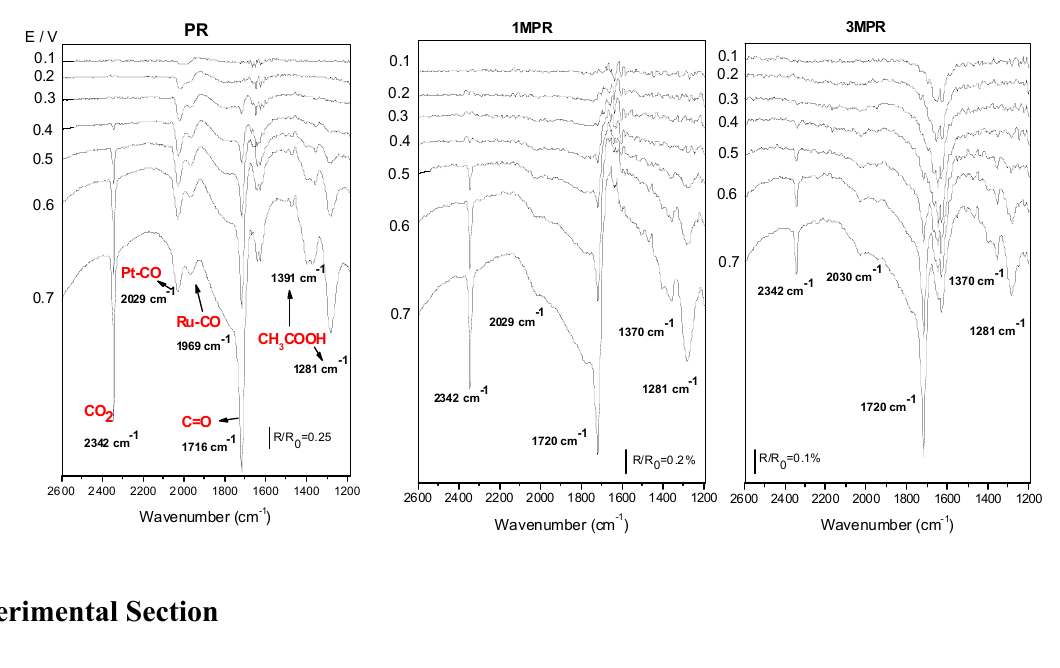
Figure 15. In situ FTIR spectra recorded during ethanol electrooxidation on the PR, 1MPR and 3MPR catalysts in 0.1 M CH Int. J. Hydrogen Energy 2012, 37 , 7131 [47]. Copyright 2012.